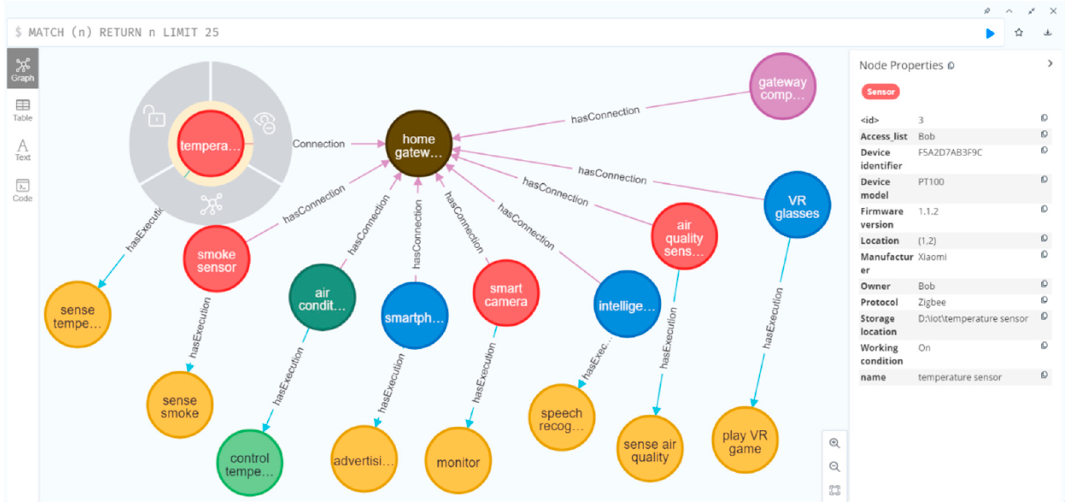
Figure 6. Network twin of IoT.